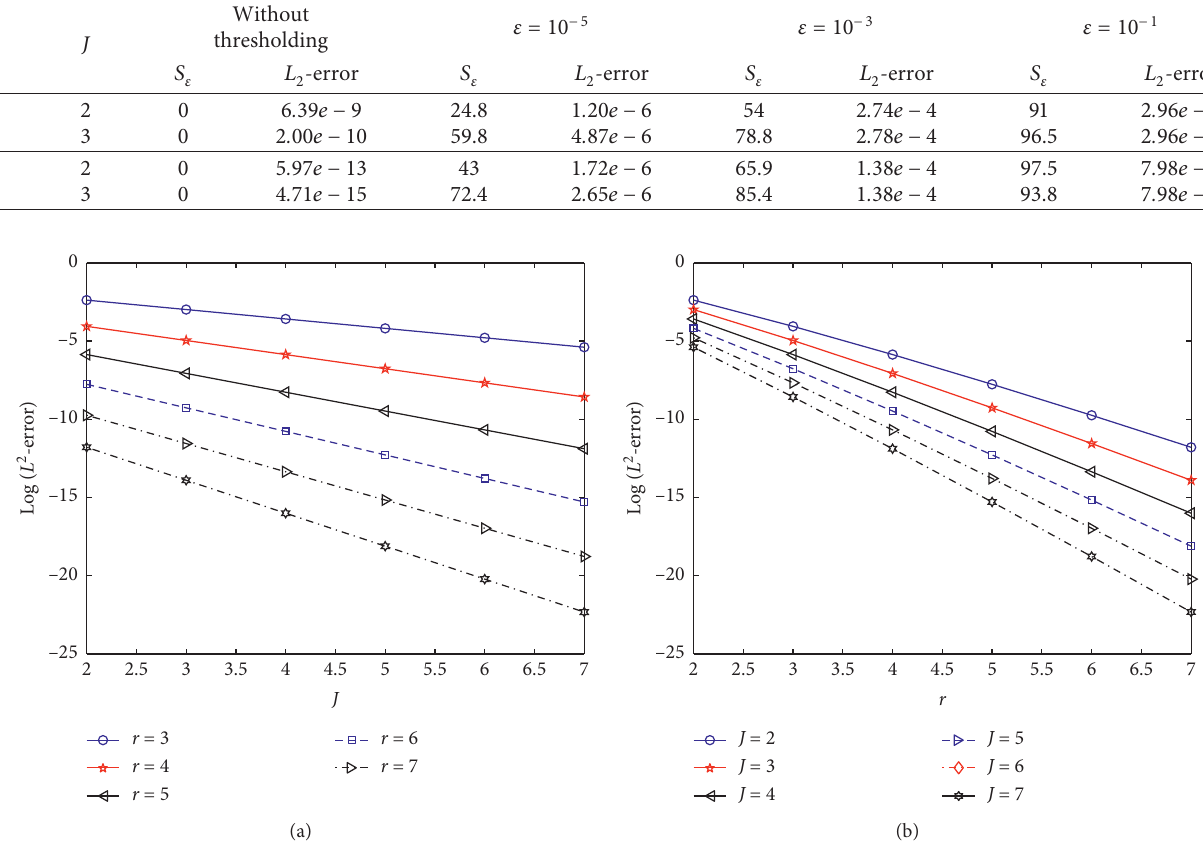
-error for Example 1. 2